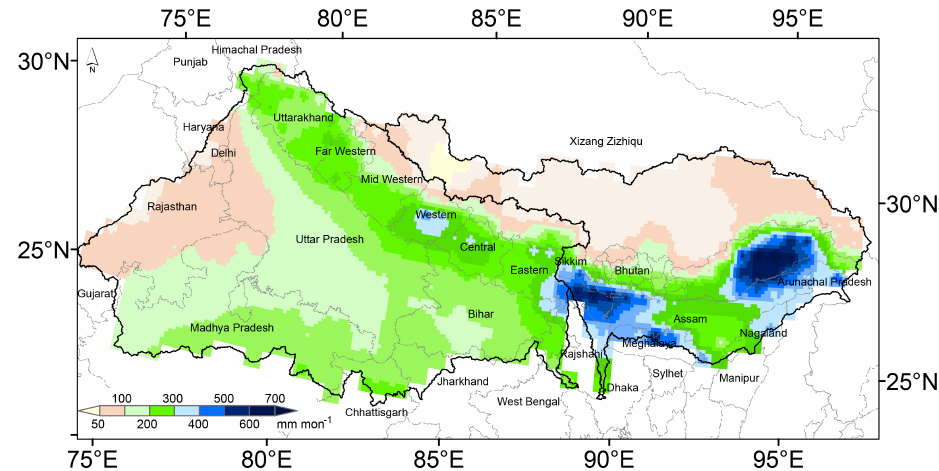
Figure 1. The Ganges and the Brahmaputra river basins overlaid by administrative boundaries. The June–October mean precipitation clima- tology (1950–2000) in mmmonth − 1 is shown by the background